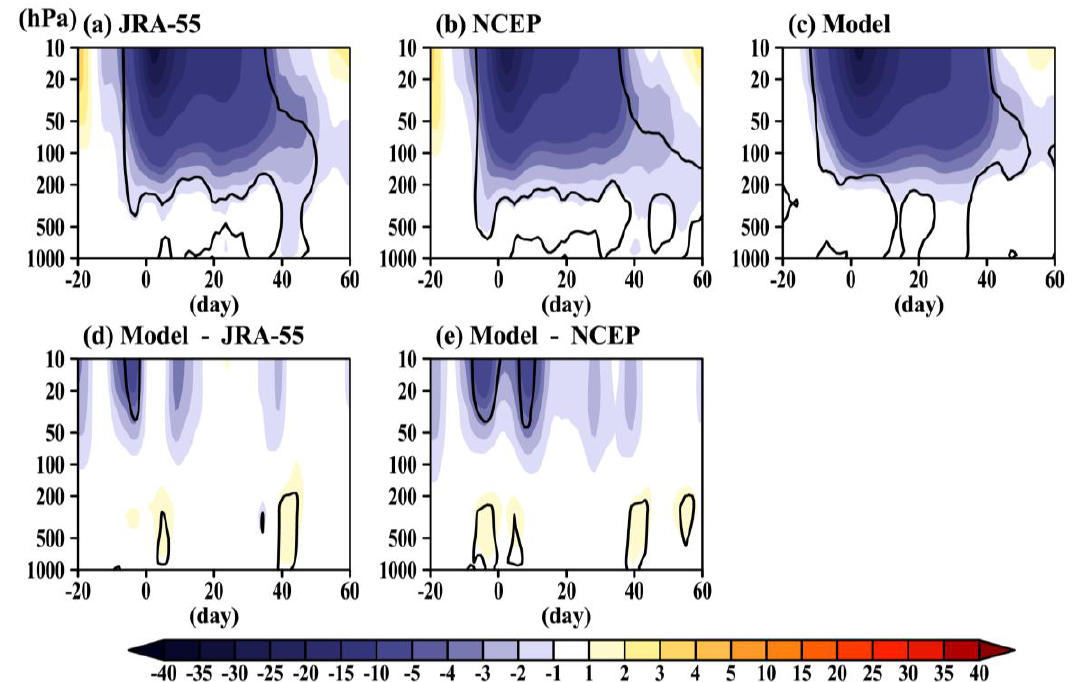
Figure 4. Composite pressure – time evolution of the zonal mean zonal wind anomalies area-averaged over 55 – 75° N (shadings; units: m/s) from day − 20 to day 60 relative to the SSW onset date for ( a ) the JRA55 reanalysis, ( b ) the NCEP/NCAR reanalysis, and ( c ) CESM1-WACCM. The last two plots ( d , e ) shows the difference between the model and the reanalyses. Black contours mark the composite zonal wind anomalies/differences at the 95% confidence level according to the t -test.